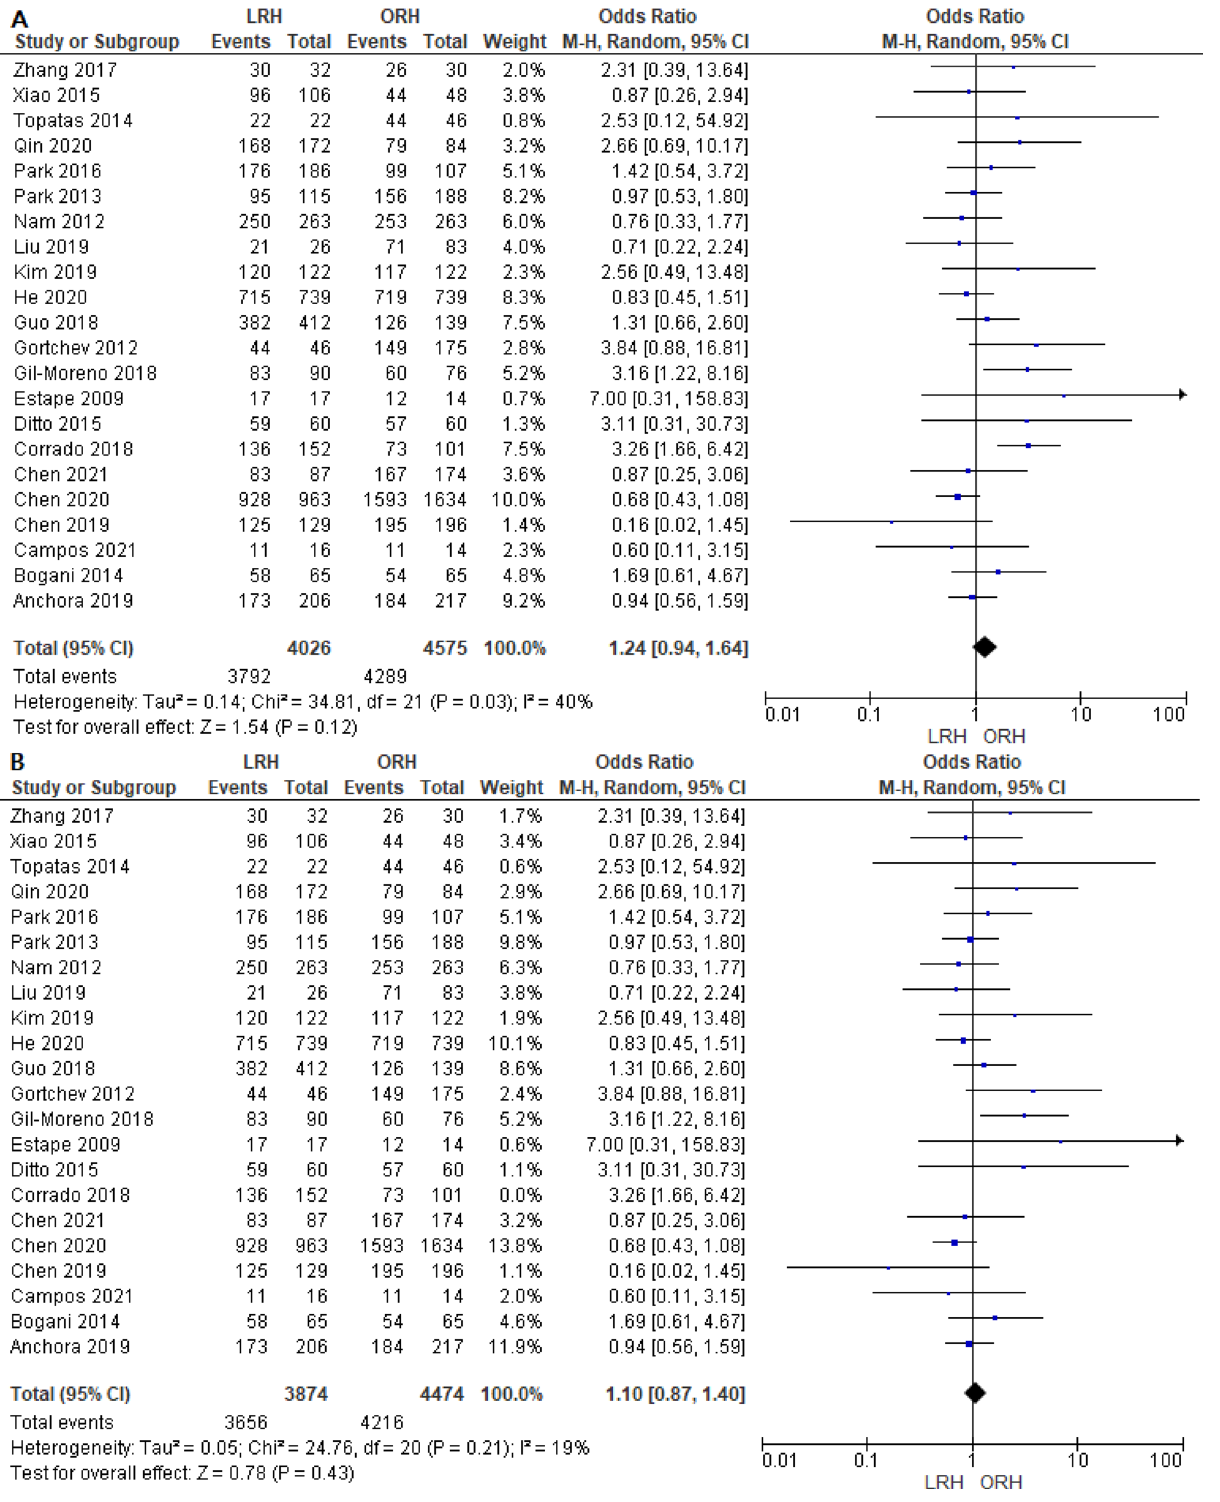
Figure 8. Forest plot of five-year overall survival before ( A ) and after ( B ) solving for heterogeneity by excluding the Corrado et al.